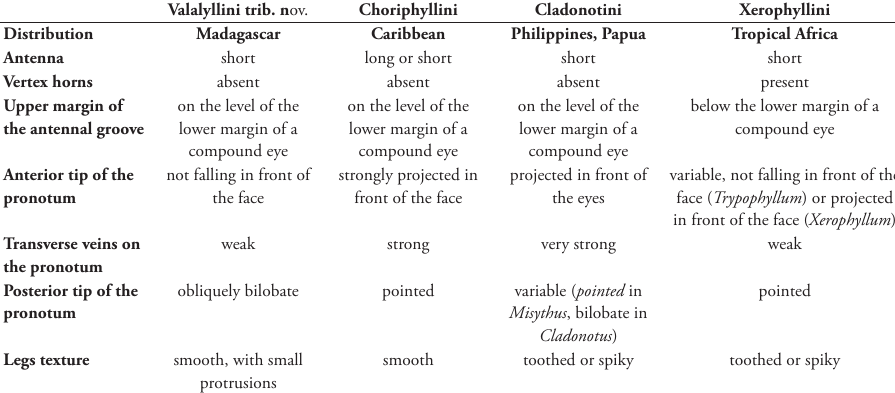
Table 1. Tabular key to the four Cladonotinae tribes with leaf-like representatives (Valalyllini trib. nov. from Madagascar, Choriphyllini from the Caribbean, Cladonotini from SE Asia, and Xerophyllini from Africa). Valalyllini trib. n ov. Choriphyllini Cladonotini Xerophyllini Distribution Madagascar Caribbean Philippines, Papua short long or short short short Vertex horns absent absent absent present Upper margin of on the level of the on the level of the on the level of the below the lower margin of a the antennal groove lower margin of a lower margin of a lower margin of a compound eye compound eye compound eye compound eye Anterior tip of the not falling in front of strongly projected in projected in front of variable, not falling in front of the pronotum the face front of the face the eyes face ( Trypophyllum ) or projected in front of the face ( Xerophyllum ) Transverse veins on weak strong very strong weak the pronotum Posterior tip of the obliquely bilobate pointed variable ( pointed in pointed pronotum Misythus , bilobate in Cladonotus ) Legs texture smooth, with small smooth toothed or spiky toothed or protrusions